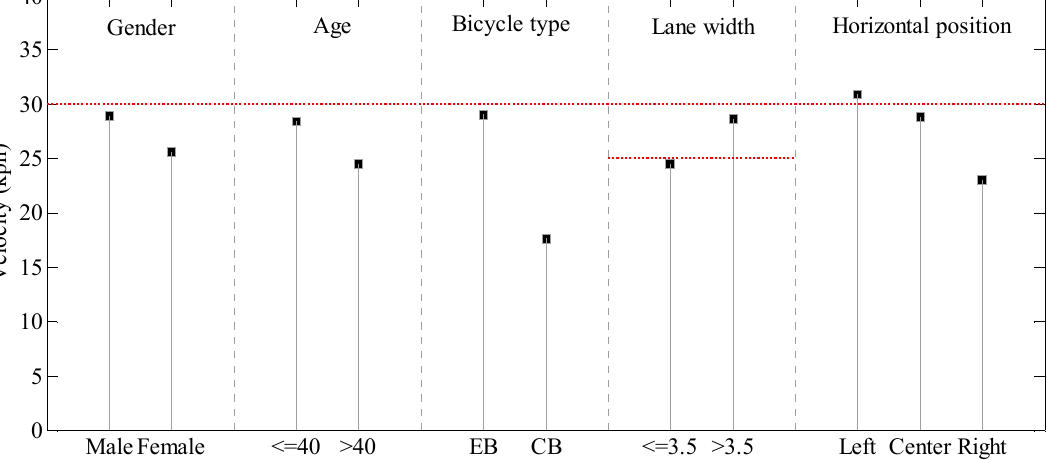
Figure 5. Eighty ‐ fifth Percentile Velocities by Gender, Age, Bicycle Type, Lane Width and Lateral Figure 5. Eighty-fifth Percentile Velocities by Gender, Age, Bicycle Type, Lane Width and Position. Lateral